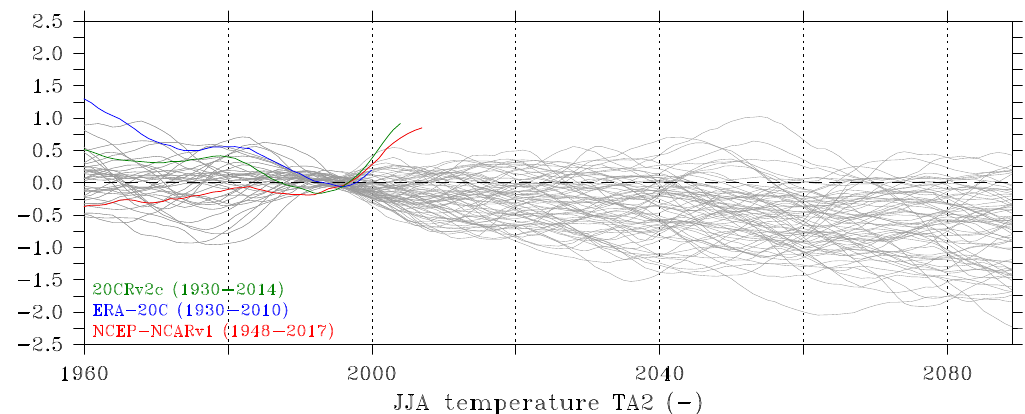
Figure 2. Similar to Fig. 1 but showing TA2 (defined in Eq. 1). Values are normalised to the 1986–2005 reference